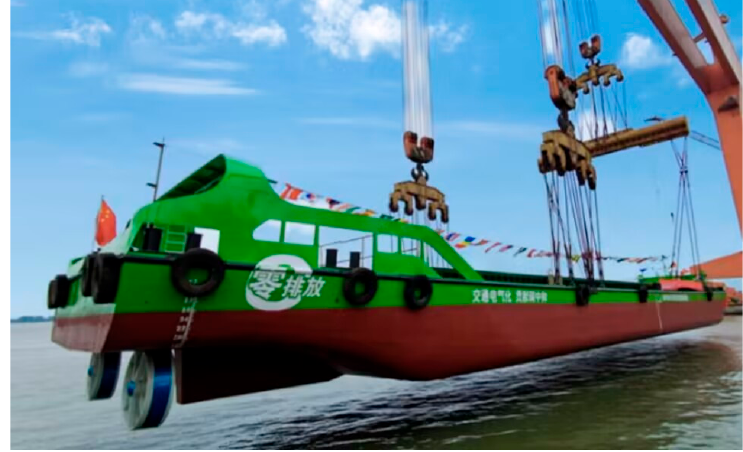
Figure 6. The 64 TEU battery-powered container ship Guochuang with zero emission.